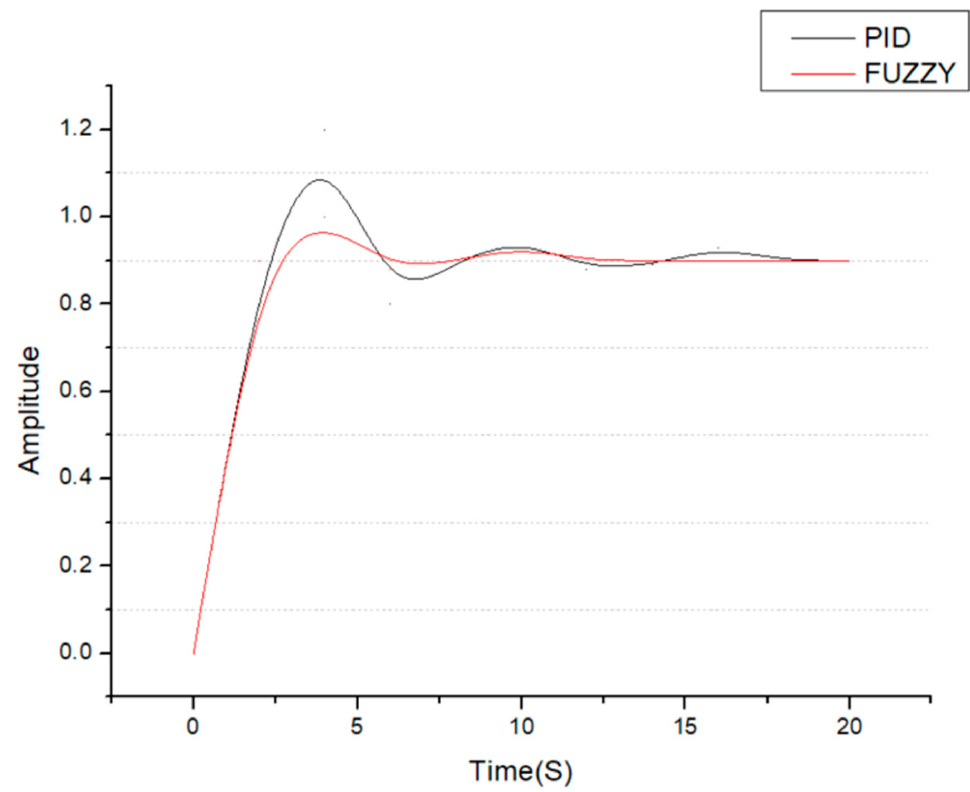
Figure 13. Comparison of traditional PID and fuzzy control step responses.